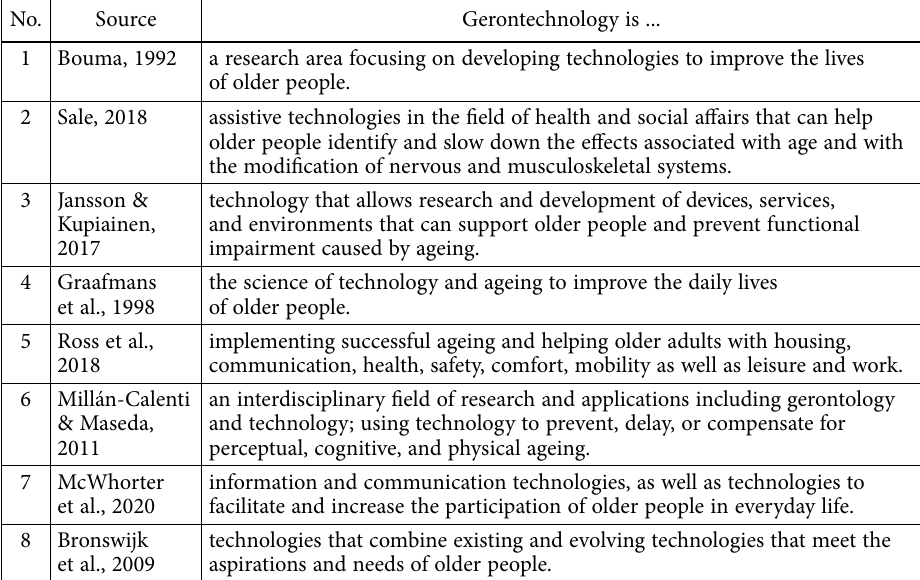
Table 2. Definition of